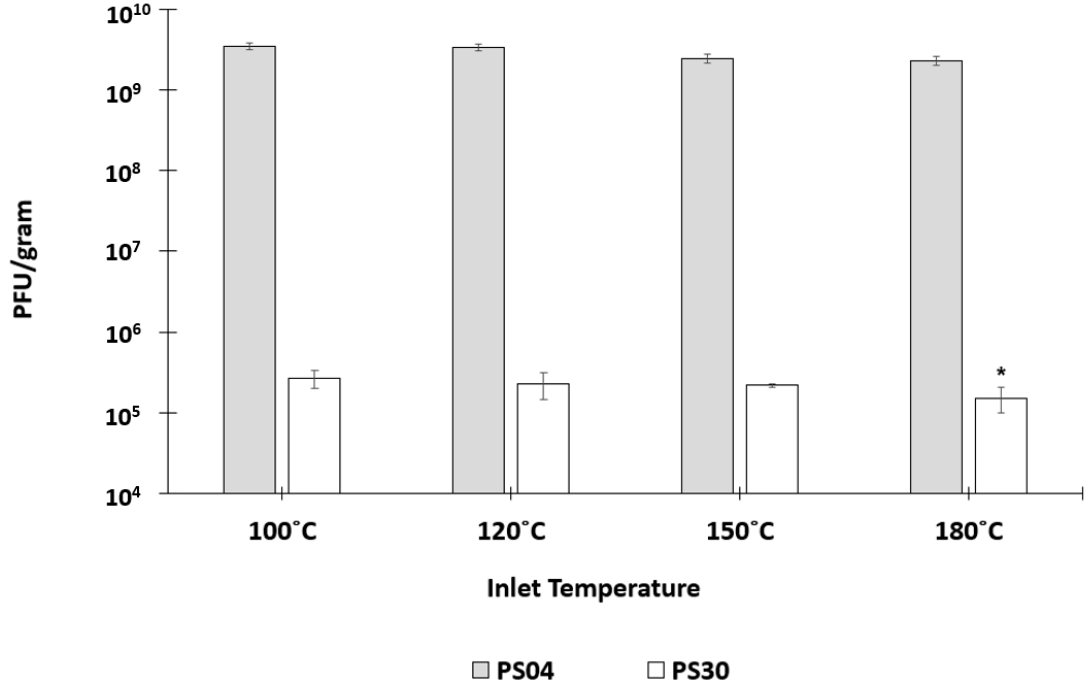
Figure 1. Phage Felix O1 spray-dried at varying inlet air drying temperatures in formulations PS04 and PS30 (see text for description) followed by complete release of phages in simulated intestinal fluid (SIF) (titre measured after 3 h of exposure to SIF). The phage titre of feed solution used for spray-drying was 5 × 10 9 PFU/mL, equating to a theoretical final phage concentration of ~1.7 × 10 9 PFU/g. * Indicates significant difference in means for samples at a given temperature compared with the spray-dried sample at 100 ◦ C for the same formulation ( p < 0.05) using a two-sample t -test. Error bars represent one standard deviation; all measurements were done in triplicate ( n = 3).